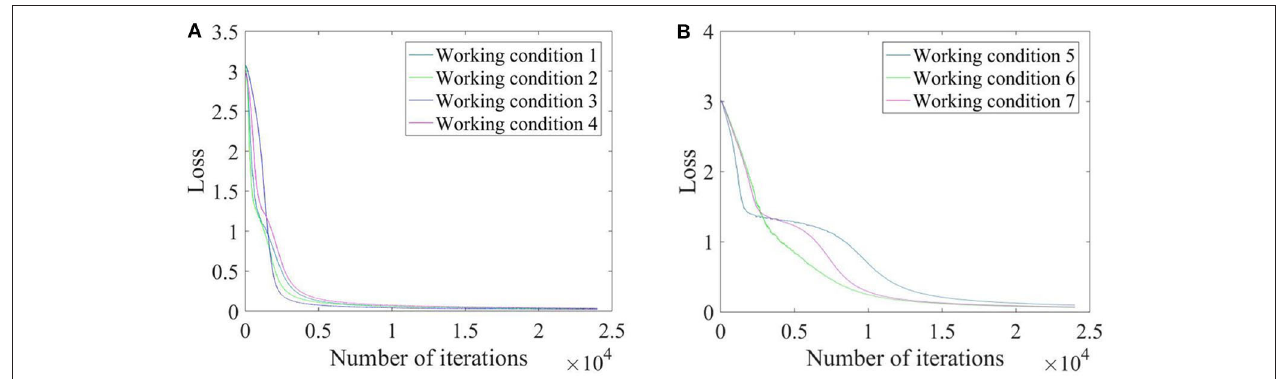
FIGURE 12 | The loss functions for each working condition during the CNN training process. (A) Working conditions 1–4. (B) Working conditions 5–7.